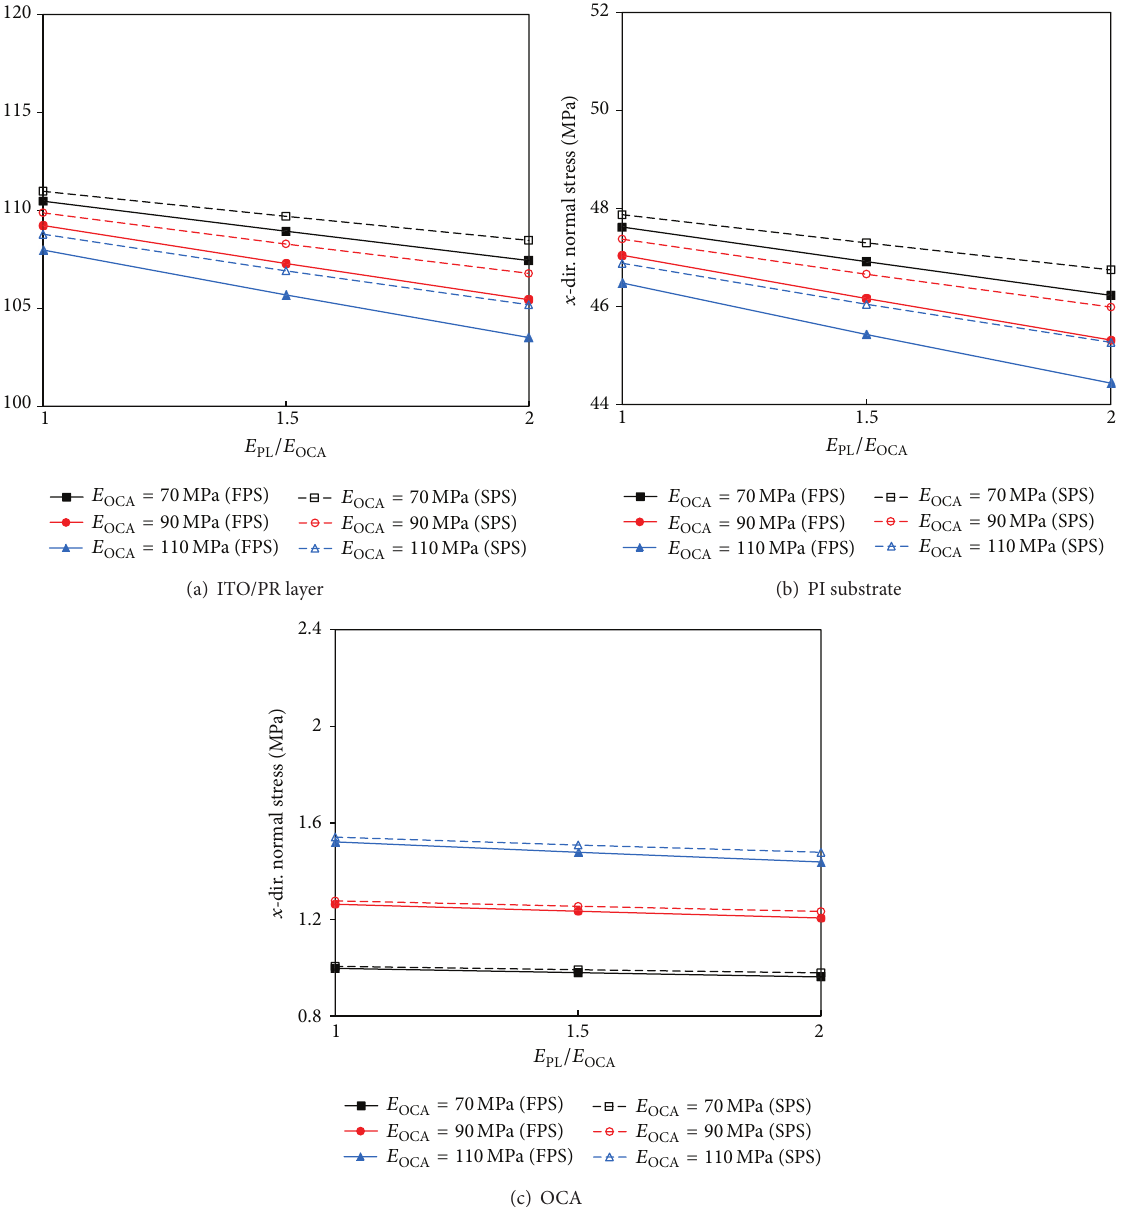
/𝐸 ratio on the bending stress of the PL OCA